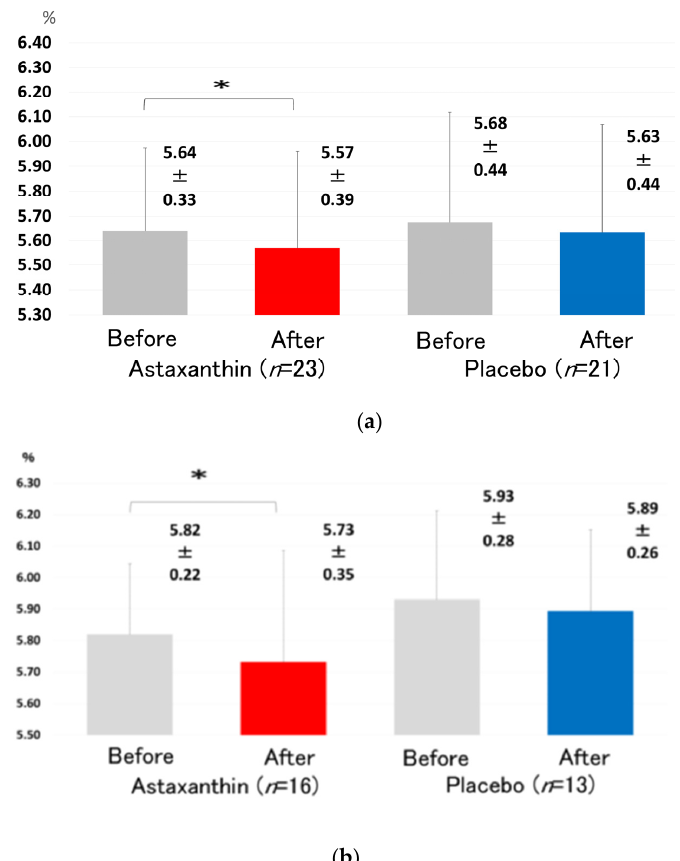
Figure 4. Changes in the levels of HbA1c before and after supplementation with 12 mg ASTX for 12 weeks. ( a ) All subjects. ( b ) Subjects with prediabetes with a HbA1c range from 5.6 to 6.4. All data are presented as the mean ± standard deviation. The Wilcoxon signed-rank test was used to test for significant differences within each group. *: p < 0.05.